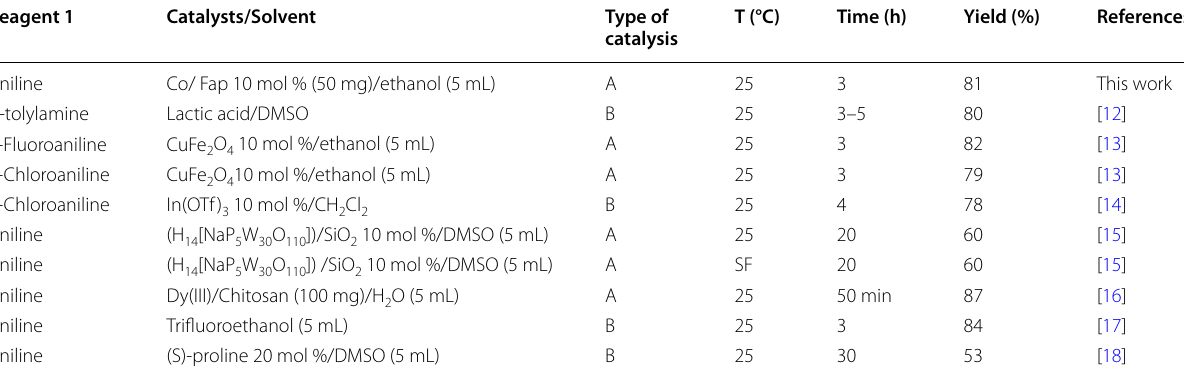
SF solvent reflux, A heterogeneous media, B homogeneous media